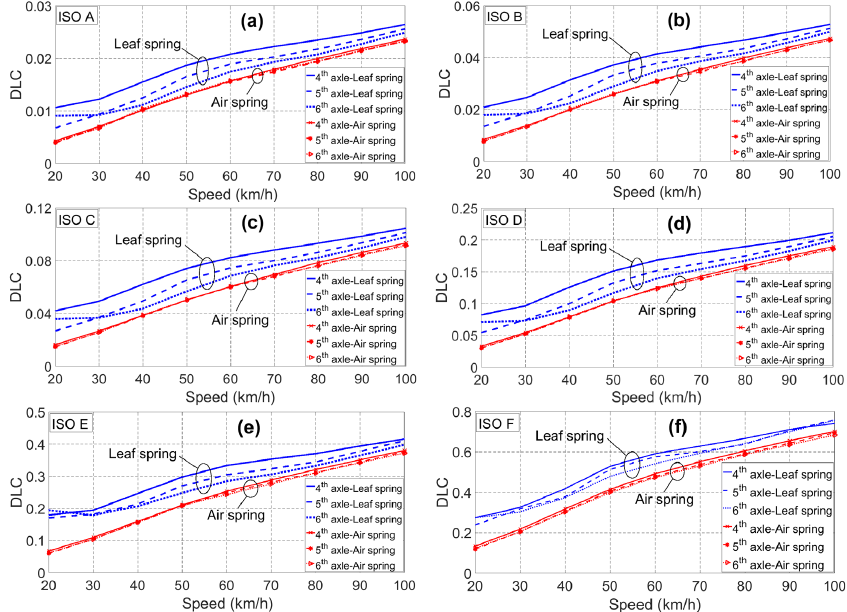
Figure 12. Comparison of DLC values respective to the two types of suspension systems: ( a ) ISO A, ( b ) ISO B, ( c ) ISO C, ( d ) ISO D, ( e ) ISO E, ( f ) ISO F .